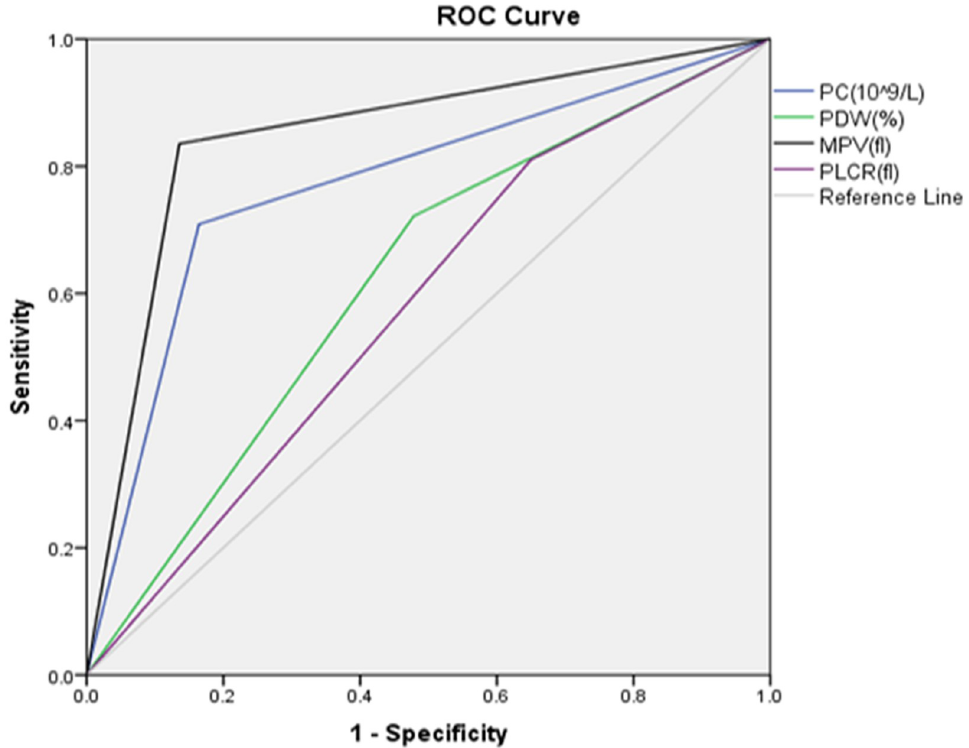
Fig 2. ROC curve of platelet parameters in pregnant women with PE visiting ACSH and MGH, Mekelle, Ethiopia, January-March 2017 (n = 219). PC-Platelet Count; MPV-Mean Platelet Volume; PDW-Platelet Distribution Width; PLCR-platelet large cell ratio.